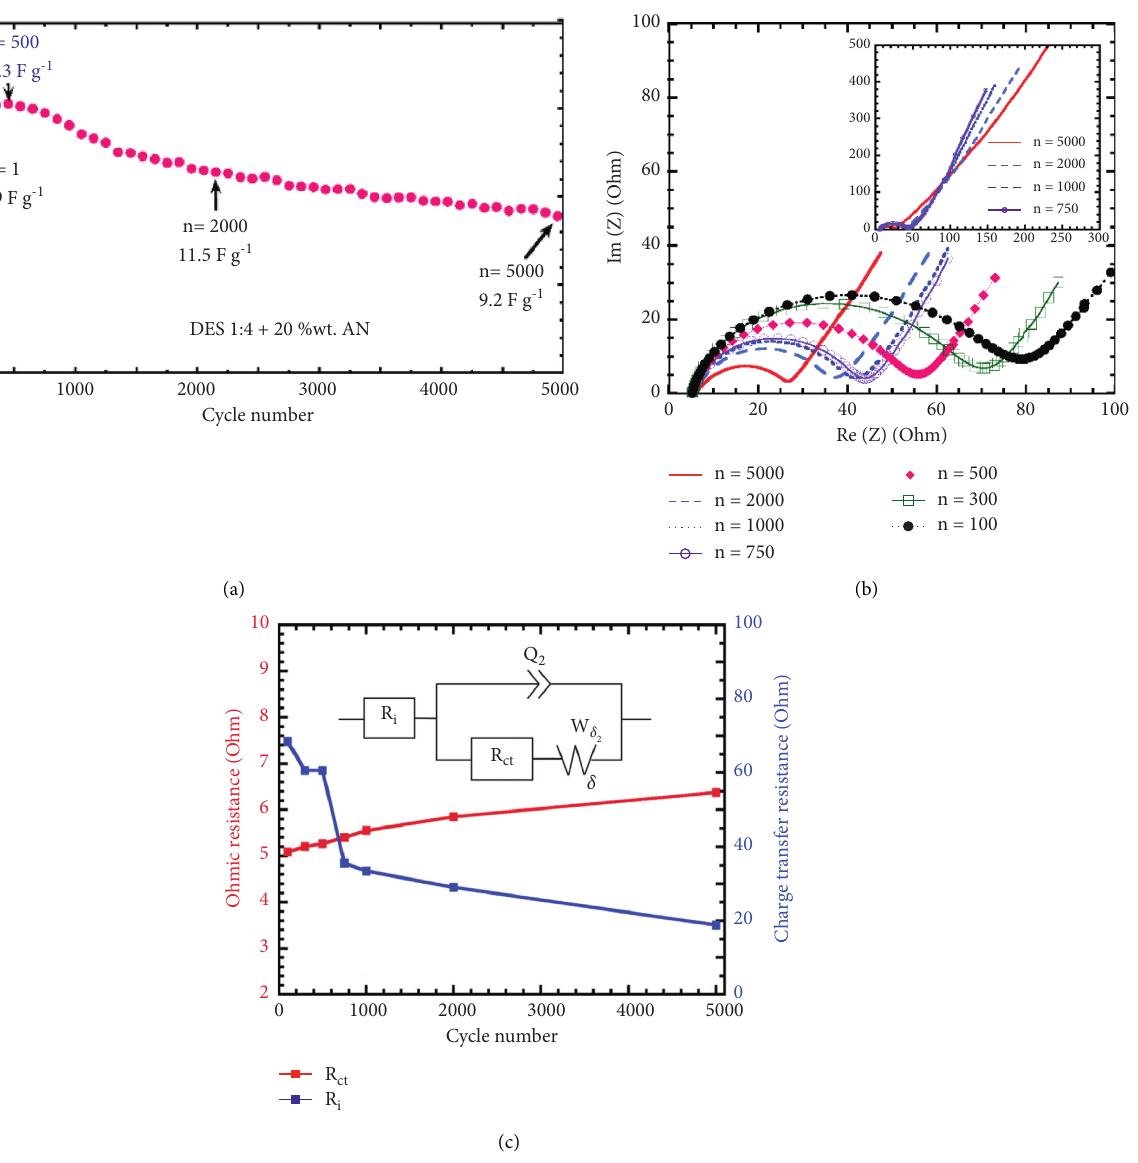
Figure 10: (a) Capacitance vs. cycle number of the DES 1:4 +20% wt. AN system at ∆ E � 3.4V and v � 1A · g − 1 . (b) Nyquist plots of the system containing 20% wt. AN after different charge/discharge cycles. (c) The charge transfer resistance ( R ct ), Ohmic resistance ( R i ) versus cycle number, and the equivalent